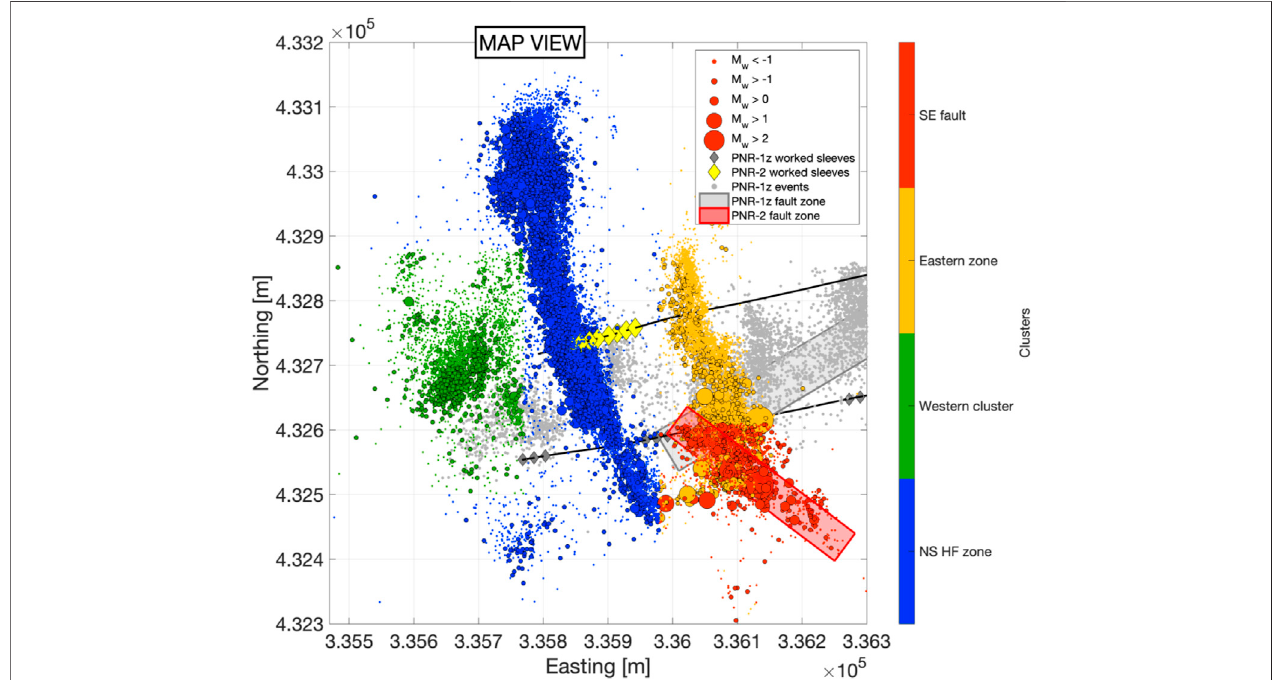
FIGURE1| MapviewofPNRmicroseismiceventlocations,sizedbymagnitudeandcoloredbycluster,focusedonthePNR-2events.Thewellpathsareshownby the black lines, and sleeve locations (the points from which each stage was injected) are shown as yellow diamonds. Coordinates shown here use the Ordnance Survey United Kingdom grid system, which continues throughout, with the background grid showing 100 m increments.